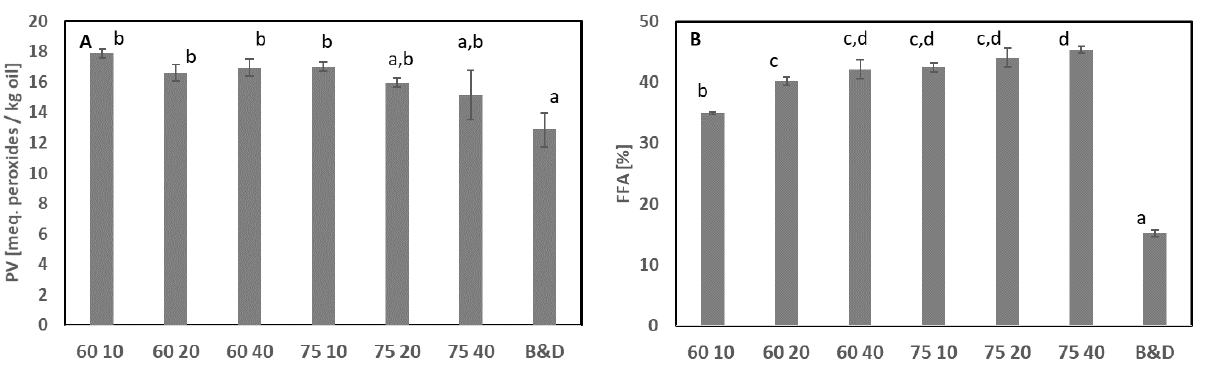
Figure 2. Effect of different extraction conditions (temperature, 60 and 70 ◦ C; time: 10, 20, and 40 min) when lipids were extracted with ethanol. The treatments were compared with B&D extraction. ( A ) Oil extracted (%), ( B ) phospholipids (%) based on oil extracted, ( C ) phospholipid-bound EPA (%), and ( D ) phospholipid-bound DHA (%). Bars and error bars indicate the average (n = 2) and standard deviation. Different superscript letters indicate significant differences. Sample abbreviation: XX YY indicates the temperature ( ◦ C) and time (min), e.g., 60 10 is 60 ◦ C for 10 min. Starfish meal from December 2019 was used.